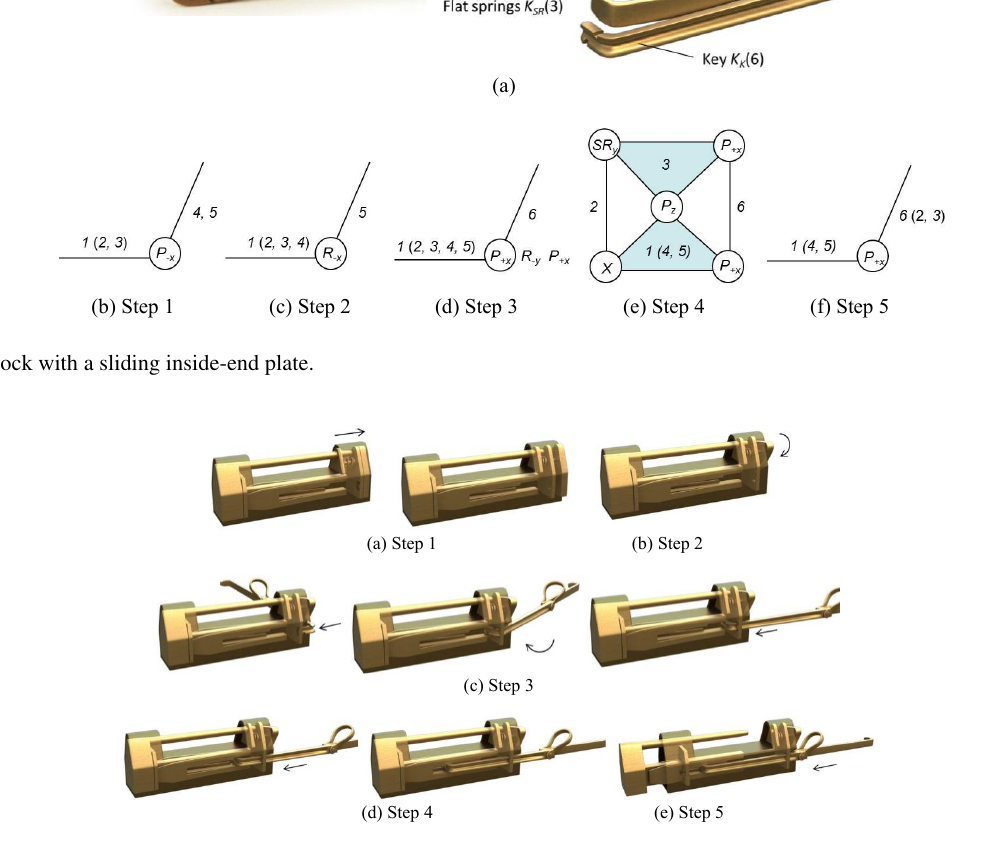
Figure 4. Animation of padlock a with sliding inside-end